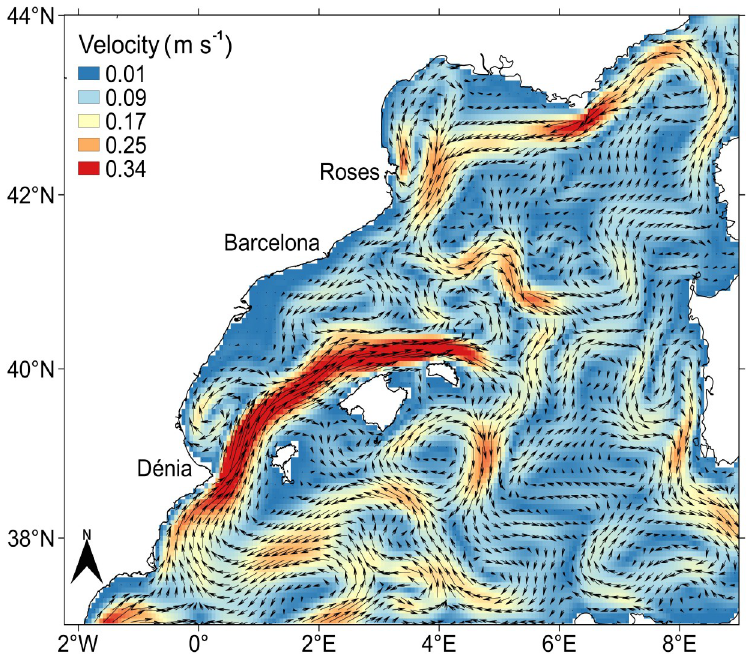
Fig 5. Mean velocity field for August 2016 at 10 m depth from CMEMS reanalysis [45]. The current velocity is depicted through the colour scale and arrows show the current direction. Coastline is from Natural Earth [41] and Instituto Hidrogra´fico de la Marina [42].